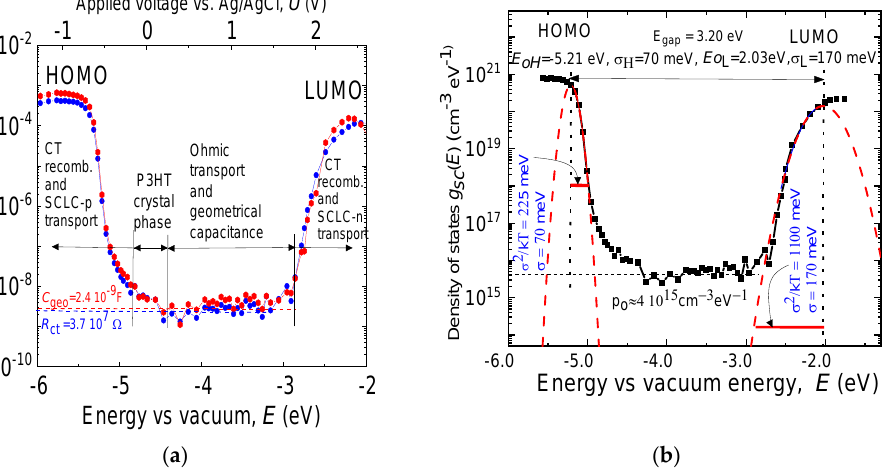
Figure 1. ER-EIS spectra of P3HT film, L = 300 nm ( a )The rough unprocessed ER-EIS data plotted as 0.1/ R ct and C sc vs applied voltage U and energy towards vacuum E ; ( b ) The bulk DOS function g sc ( E ) (black) (calculated from ( a ) and Equation (3)) with the denoted Gaussian distributions (red).